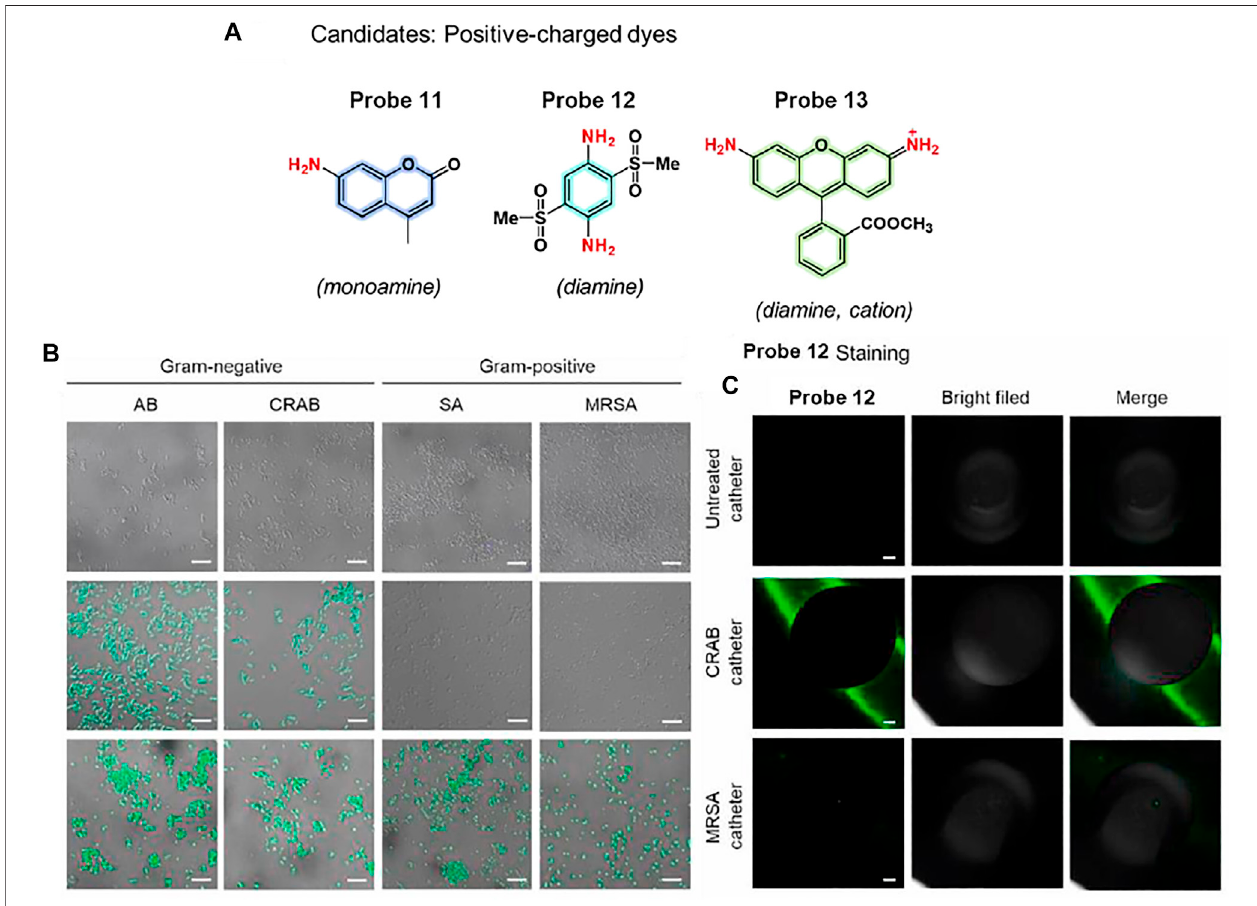
FIGURE 7 | (A) Chemical structures of probes 11 – 13. (B) Confocal microscopic images of bacteria incubated with probes 11 (top), 12 (middle), and 13 (bottom). (C) CRAB detection of catheter segments using probe 12. Reproduced with permission from Kang et al. (2021). Copyright © 2020, Elsevier.